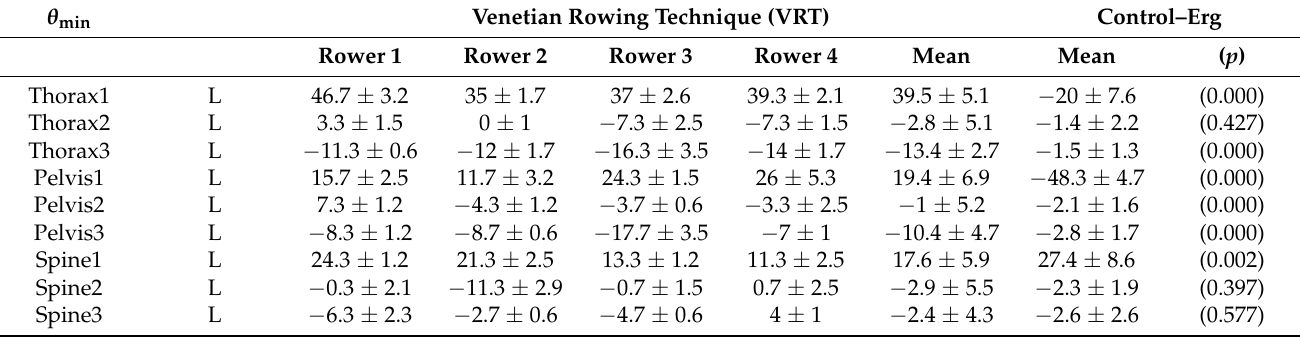
Table 2. The minimum values, θ min , of the thorax, pelvis and spine angles measured for the Venetian style rowing technique, in degrees, ± 1 s.d., for the individual rowers 1–4, their mean, and its equivalent mean value for standard ergometer rowing, with p -value for these two means reported in